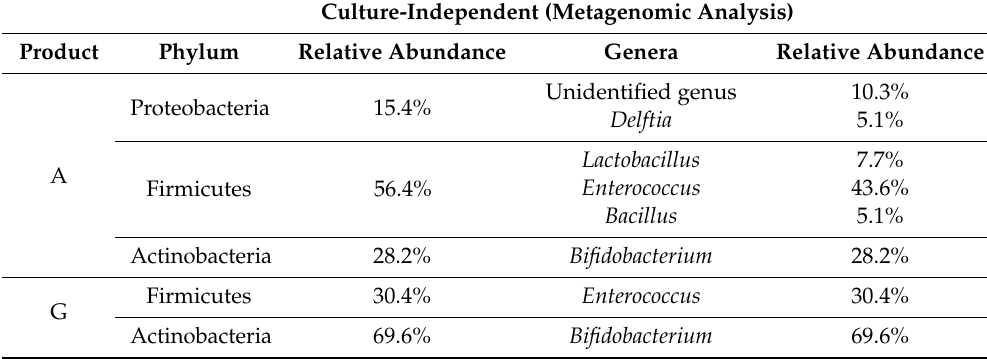
Table 2. Bacterial composition of products A and G based on their label claims, determined by culture-dependent 16S rRNA sequencing and metagenomic analyses of the 16S rRNA